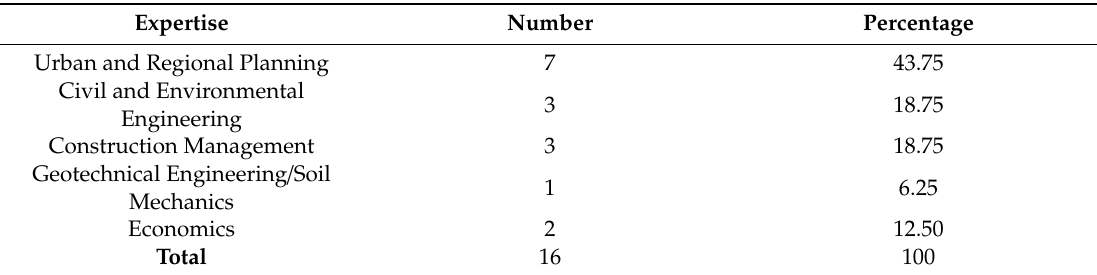
Table 1. The survey respondents by expertise.